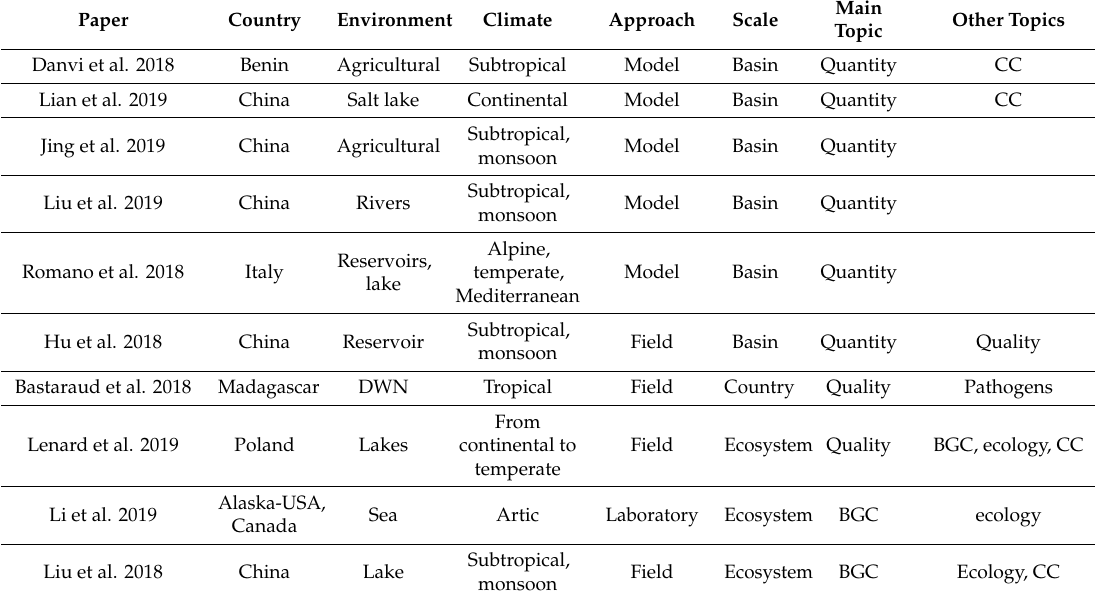
Table 1. Summary of the paper contents in this special issue. Papers are sorted based on the main topic first and on the country secondarily. DWN = drinking water network; BGC = biogeochemistry; CC = climate